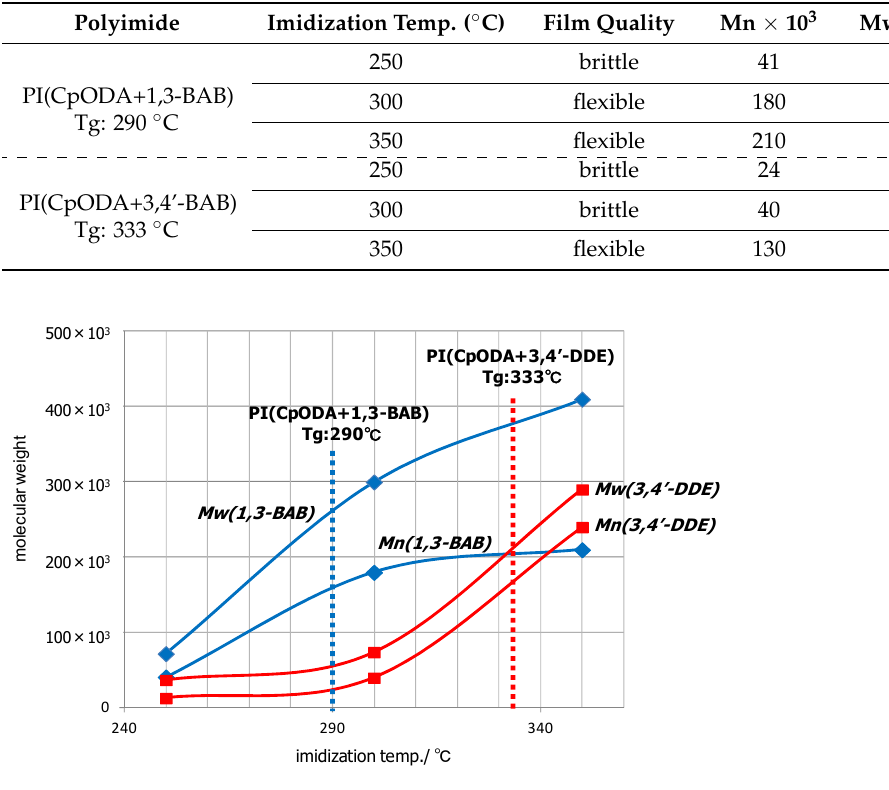
Figure 2. Number-averaged (Mn) and weight-averaged (Mw) molecular weights as a function of imidization temperature in CpODA-based polyimides. The Tg of the polyimides are indicated with vertical dotted lines (blue: PI(CpODA+1,3-BAB); red: PI(CpODA+3,4 ′ -DDE)).